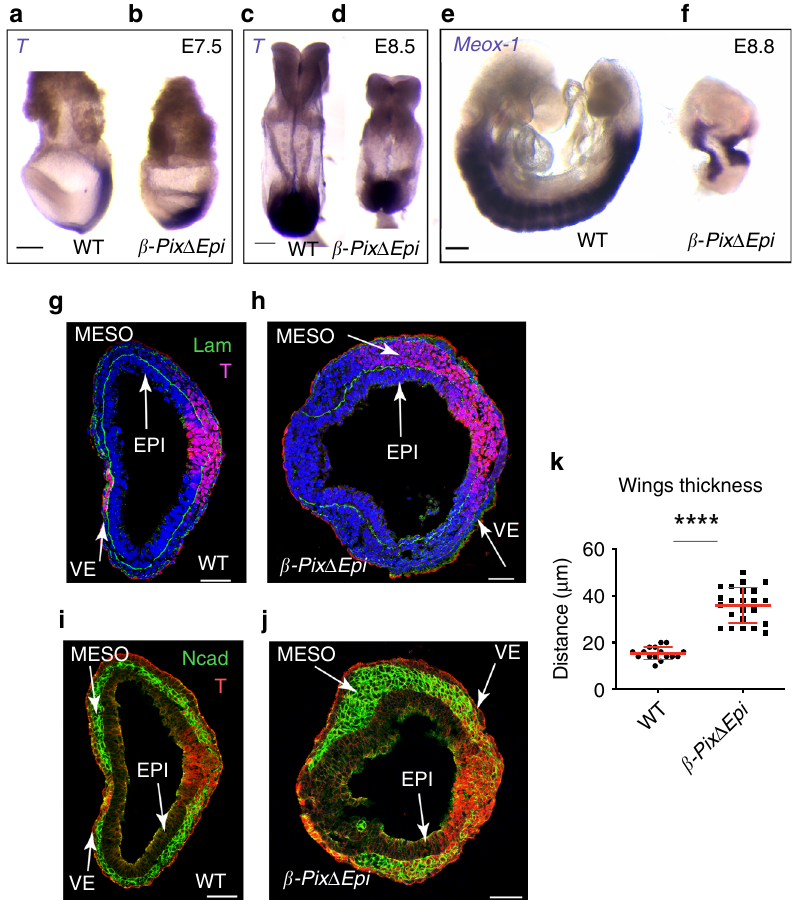
Fig. 1 Arhgef7/ β -Pix is required for mesoderm morphogenesis at gastrulation. a – f Phenotypes of β -Pix Δ Epi mutant embryos. In situ hybridization analysis of Brachyury ( T ), a marker of the primitive streak, expressed in all nascent mesoderm ( a – d ) showing streak shortening in β -Pix Δ Epi mutant embryos ( b ) as early as late bud stage/early headfold (E7.5); posterior to the right. At E8.5 β -Pix Δ Epi mutant embryo ( d ) shortening is evident; posterior is down. In situ hybridization analysis of Meox1 , a marker of paraxial mesoderm ( e , f ) showing that somites fail to form ( f ) in β -Pix Δ Epi mutant embryos ( g – j ). Transverse single confocal sections of early headfold (E7.5) stage embryos ( g , h ); mutants show an expanded primitive streak, marked by the enlarged region of Laminin breakdown and expanded T expression ( h , j ). N-cadherin expression marks the mesodermal wings, which are thicker in β -Pix Δ Epi mutant embryos ( j ). k Thickness of mesodermal wings in mutant E7.5 embryos is signi fi cantly increased, n = 16 measurements/4 wild-type embryos, n = 23 measurements/6 mutant embryos; mean ±s.d. **** p <0.0001 by both two-tailed Student ’ s and one-way ANOVA tests. Scale bars, 150 µ m ( a – f ), 50 µ m ( g – j